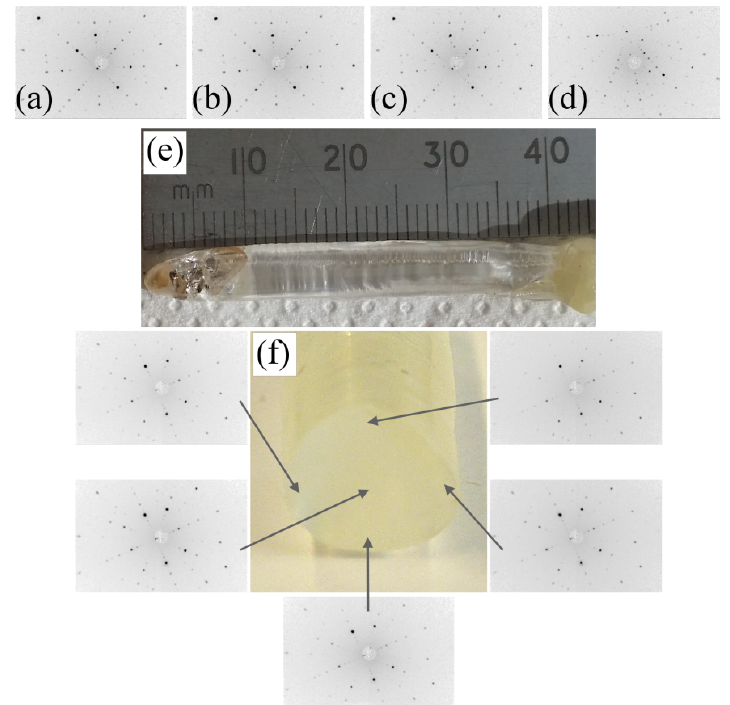
Figure 5. ( a – d ) X-ray Laue back reflection photographs of one of the facets of a La 2 Zr 2 O 7 crystal, taken along the crystal length at „ 12 mm intervals, between the end (left) and the beginning (right) of the boule. The corresponding Laue patterns taken on the facet at 180 degrees are mirror images of these patterns; ( e ) Boule of La 2 Zr 2 O 7 prepared by the floating zone method in air at a growth rate of 15 mm/h; ( f ) Laue patterns taken of the cross section of the boule at „ 15 mm from the beginning of the boule, are consistent with one another at several points covering the entire surface. Five patterns corresponding to scans across the diameter of the boule, taken at „ 2 mm intervals, are